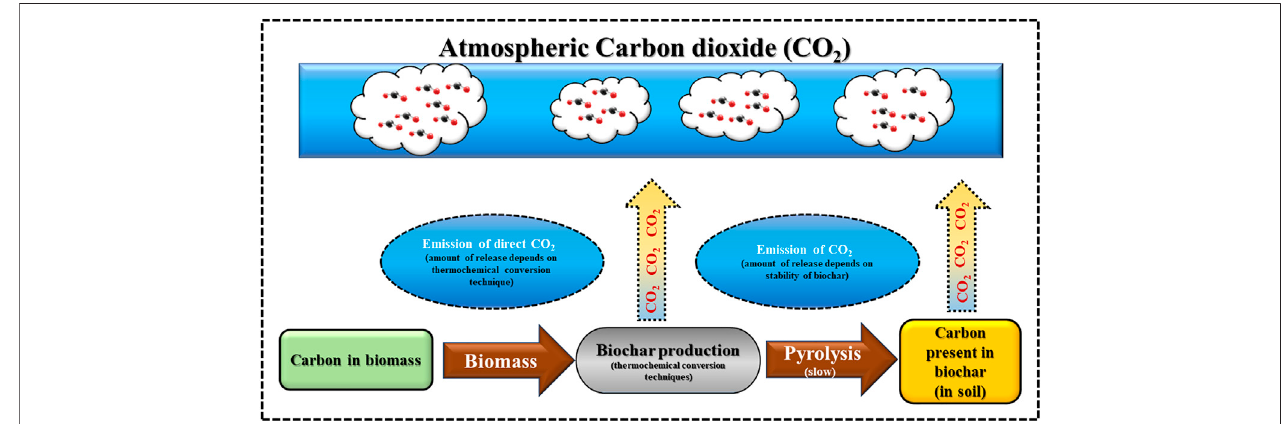
FIGURE 11 | Impact of biochar production on the carbon cycle (adapted from Meyer et al., 2011).